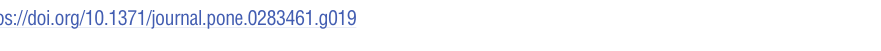
PLOS ONE | https://doi.org/10.1371/journal.pone.0283461 March 30,